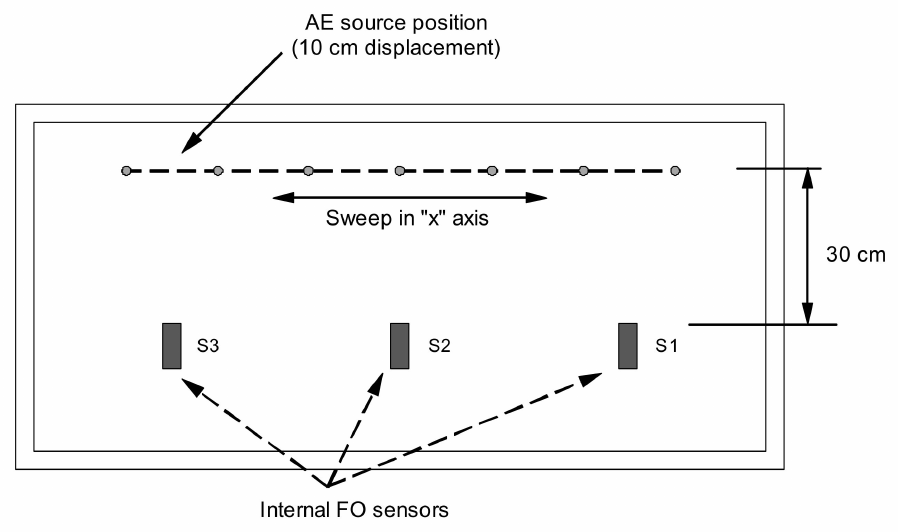
Figure 14. Experimental arrangement used for the location of the AE source in X axis